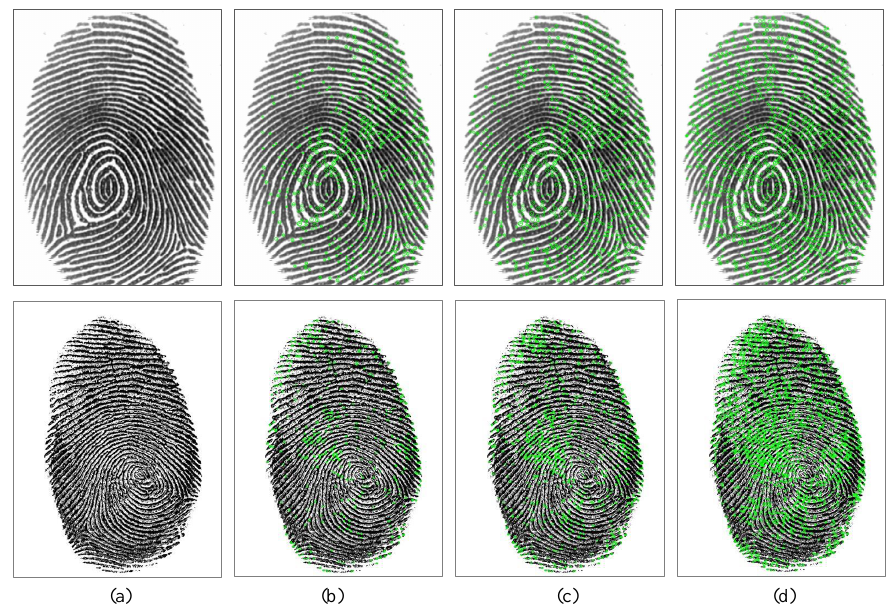
Figure 7. SIFT minutiae detection for various threshold values: ( a ) source image and detected frames at threshold values of ( b ) 5.0, ( c ) 7.5, and ( d )